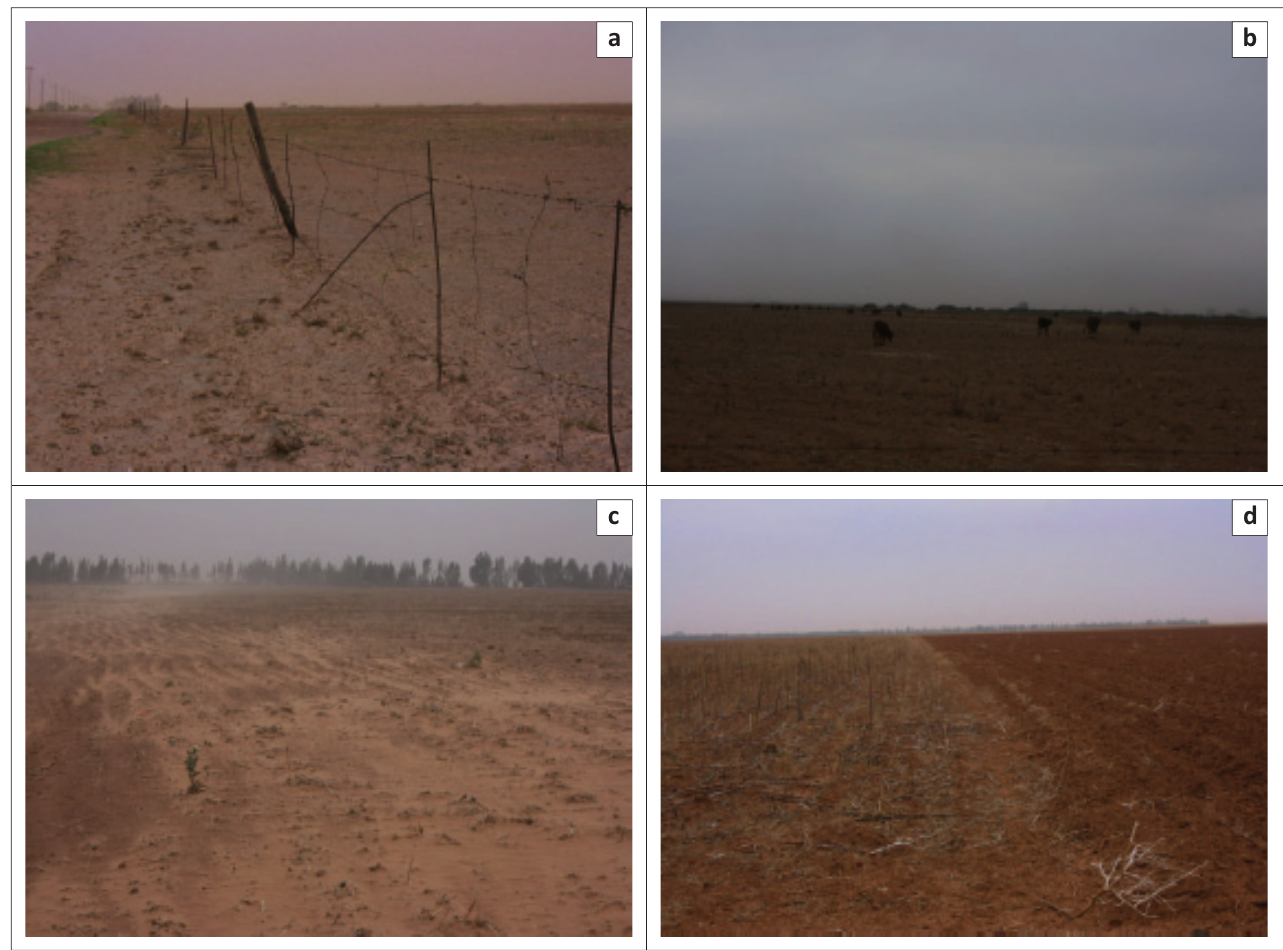
FIGURE 3: Photographs taken in 2016 in the Mooifontein farming region. (a) Dilapidated infrastructure near Brooksby is a common sight, (b) Thin herd animals scrounging for food in a drought-stricken cropping land near Enselsrust, (c) Ploughed lands wait for rain. The livestock have eaten all the dry matter left after the harvest, and (d) Cropping fields near Brooksby: the contrast between lands tilled by a mould-board plough (right) and no-tills lands